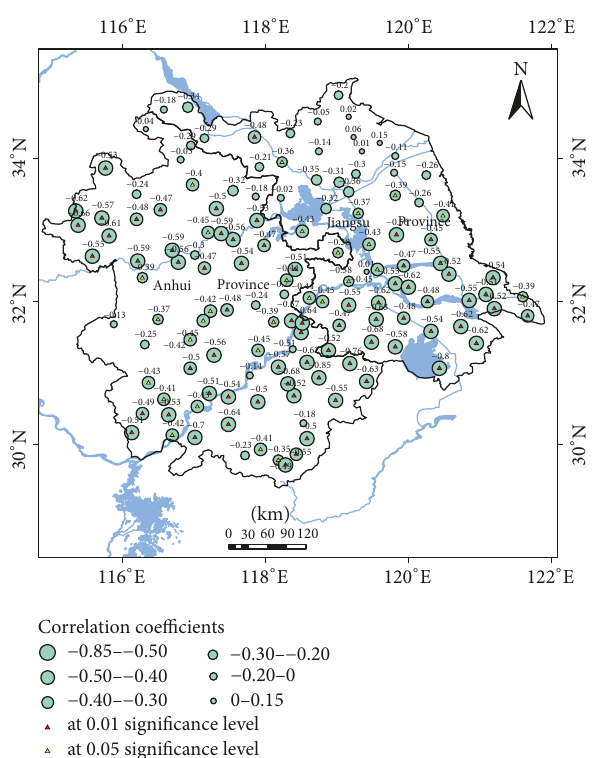
Figure 3: Correlation coefficients between the relative meteorolog- ical yield of winter wheat and PAP in spring. The yellow and red filled triangles refer to the correlation coefficients at the 0.05 and 0.01 significance levels,